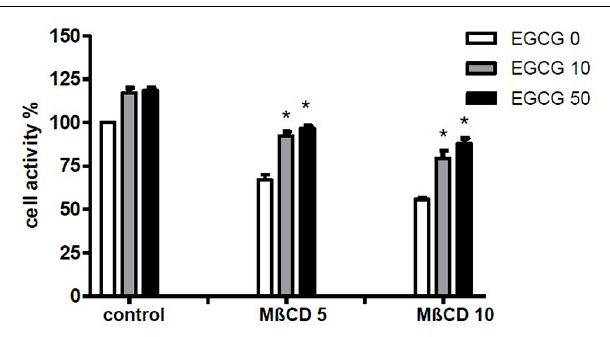
FIGURE 4 | Effect of EGCG on cell damage induced by M β CD. Cells were preincubated 45 min with M β CD at the indicated concentrations and treated with EGCG. Cell activity was then evaluated after 24 h.The values are expressed as the mean ± SD; M β CD expressed as millimolar; EGCG expressed as micromolar. Data are representative of one of three independent experiments ± SD of three replicates. * p < 0.05 vs EGCG 0.